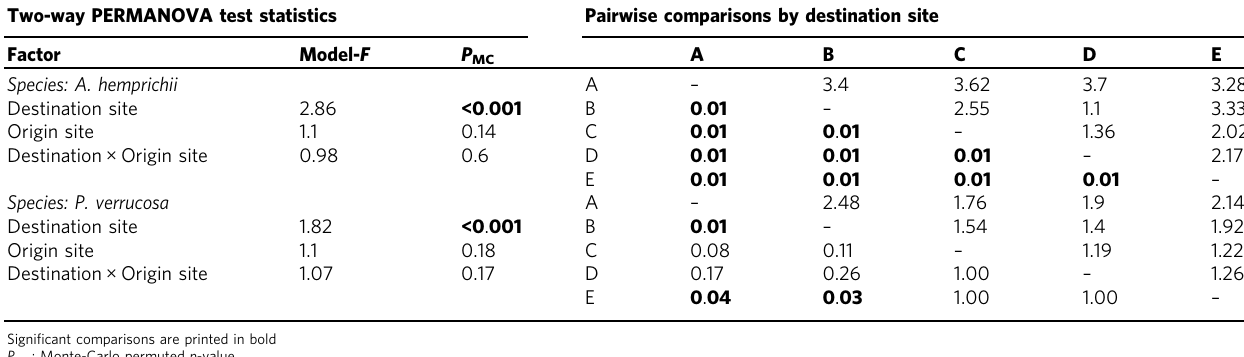
Signi fi cant comparisons are printed in bold P MC : Monte-Carlo permuted p -value Pairwise comparisons: lower triangle p -values, upper triangle Model- F values Tests were conducted separately for the corals Acropora hemprichii and Pocillopora verrucosa after 21 months of reciprocal